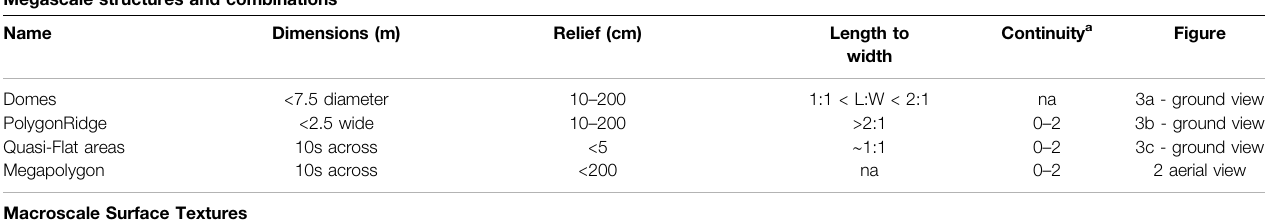
TABLE 2 | Macroscale and microscale structures and textures observed in the fi eld at Salar de Pajonales. Megascale structures and